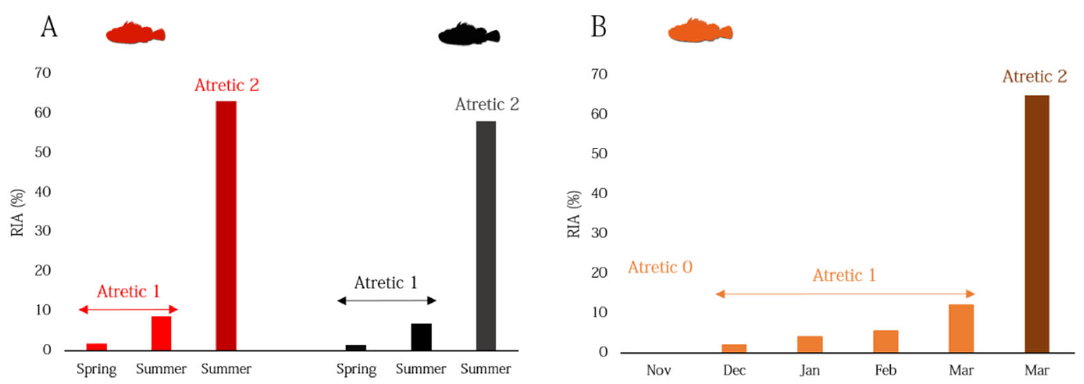
Figure 9. Relative intensity of atresia (RIA) through the spawning season in females of Scorpaena scrofa and S. porcus ( A ) and Helicolenus dactylopterus ( B ). Atretic 0: ovaries with 0% of SG oocytes with α -atresia; Atretic 1: ovaries with <50% of SG oocytes with α -atresia; Atretic 2: ovaries having ≥ 50% SG oocytes with α -atresia. In Scorpaena species date are expressed per season, while in H. dactylopterus per month.